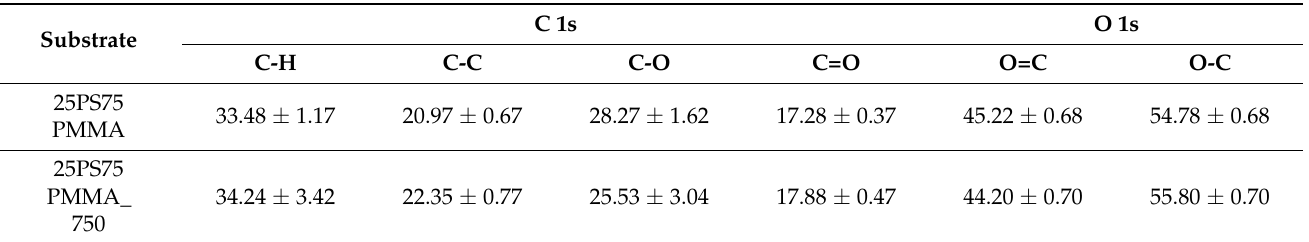
Table 3. XPS derived average (n = 3) % atomic concentration of the C 1s and O 1s deconvoluted components for 25PS75PMMA and 25PS75PMMA_750 substrate surface.